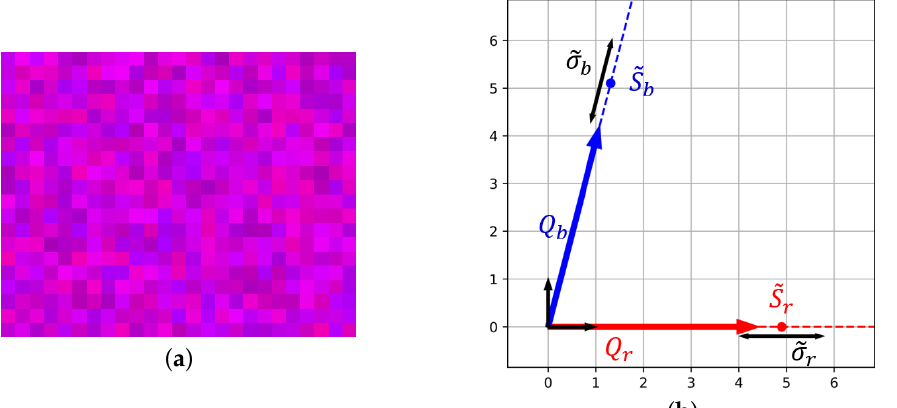
Figure 5. ( a ) Visual results of raw acquisition with superposed red and blue channel, ( b ) locations of the raw points and raw noise segments in the sensor space (cid:101) S i and (cid:101) σ i